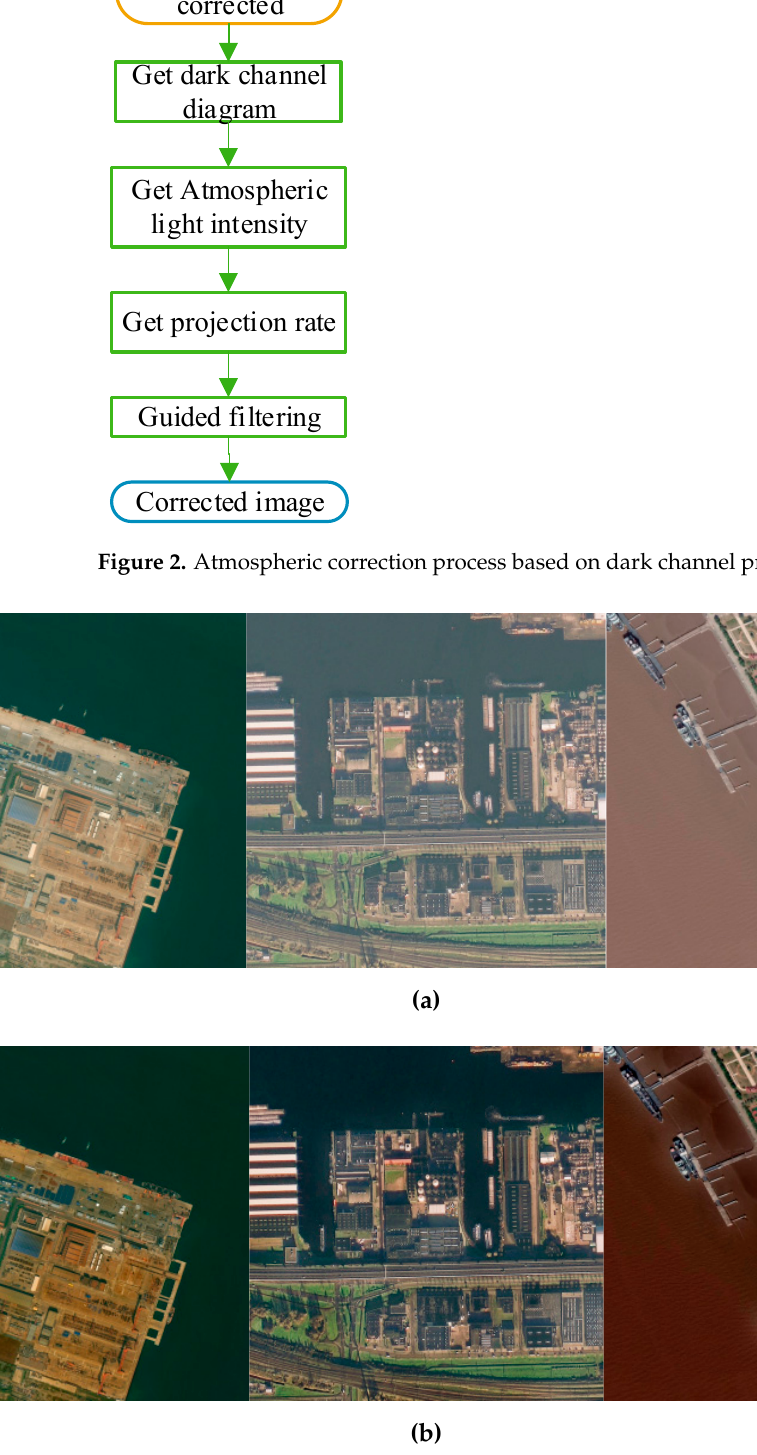
Figure 3. Images before and after atmospheric correction: ( a ) images before correction; ( b ) corrected images.